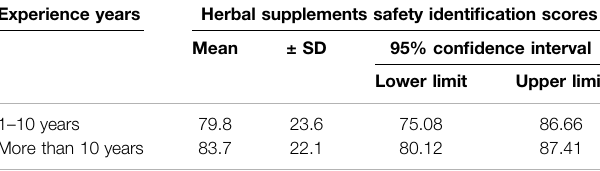
TABLE 4 | Substandard and falsi fi ed herbal supplements identi fi cation scores by experience years. Experience years Herbal supplements safety identi fi cation